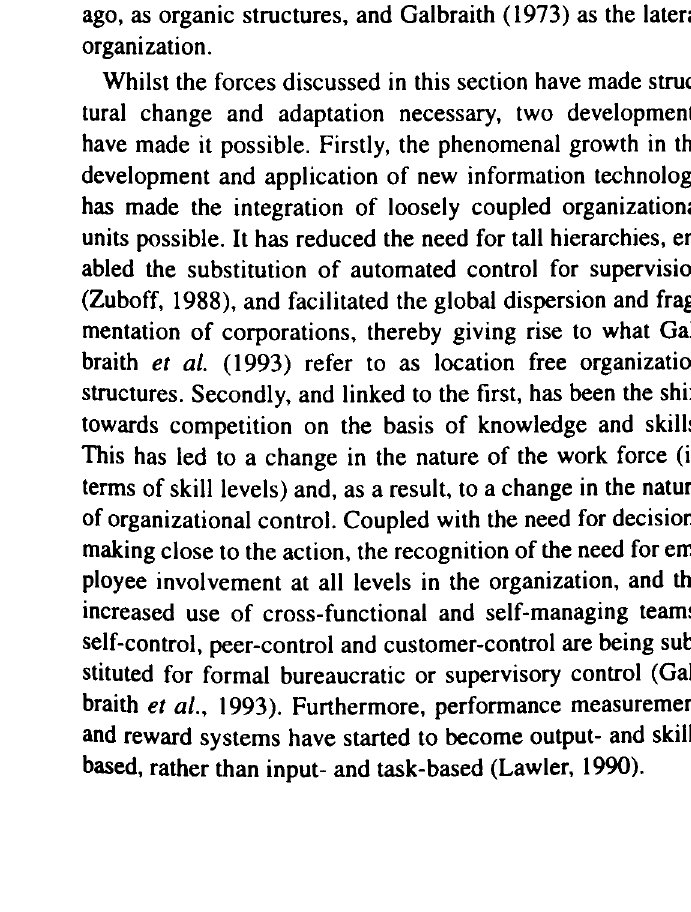
Table 1 Different meanings of network